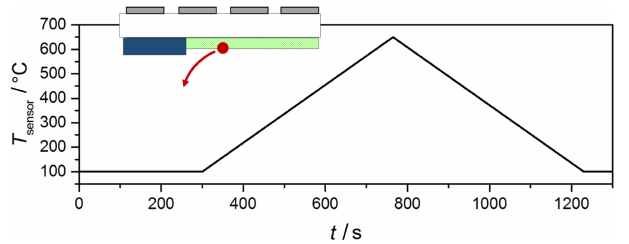
Figure 8. Modulation of the overall sensor temperature T sensor over time as implemented in the simulation. The inset scheme illustrates at which point the temperature was